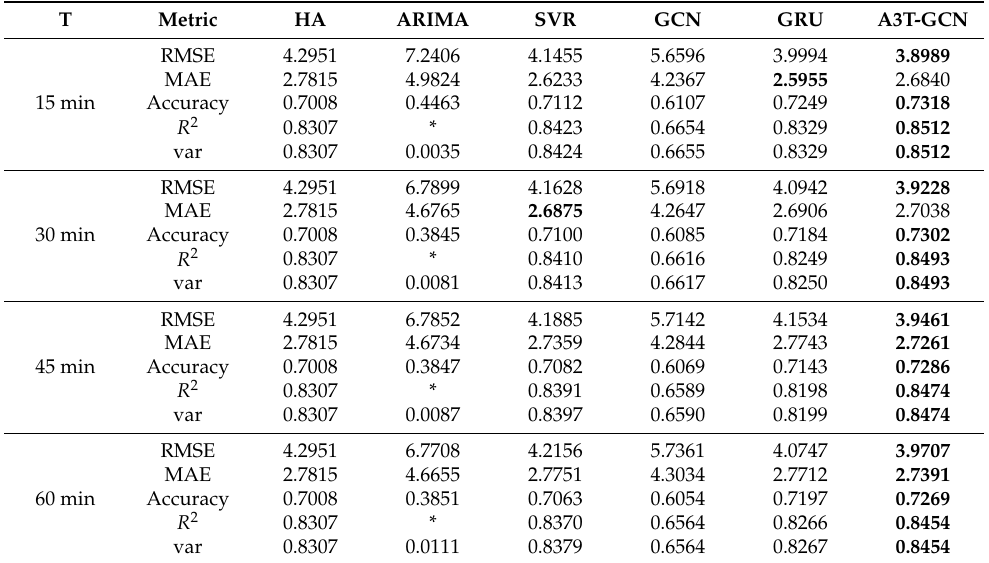
Table 1. The prediction results of the A3T-GCN model and other baseline methods on the SZ-taxi dataset.